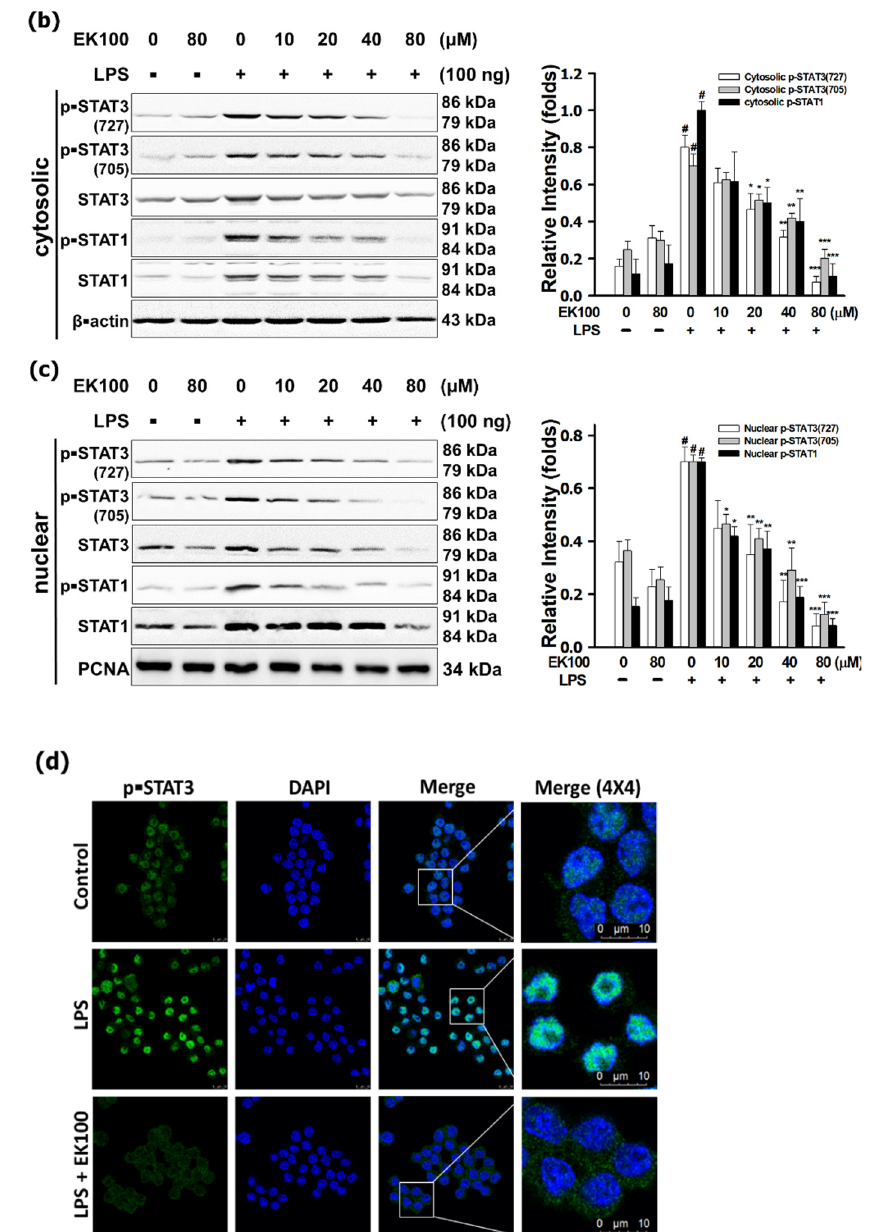
Figure 4. EK100 suppressed the MAPK/AP-1 pathways in LPS-stimulated RAW 264.7 cells. Cells were treated with 0, 10, 20, 40, and 80 µM EK100 for 1 h before being stimulated with 100 ng/mL LPS for 6 h. ( a ) The phosphorylation protein expressions JAK1/2 were analyzed. ( b ) The phosphorylation protein expressions p-STAT1 (705), p-STAT3 (727), and p-STAT3 (705) in the cellular cytoplasm were analyzed. ( c ) The phosphorylation and protein expression in the cellular nucleus of p-STAT1 (705), p-STAT3 (727), and p-STAT3 (705) were analyzed. ( d ) Cells were treated with 80 µM EK100 for 1 h before being stimulated with LPS for 6 h. p-STAT (Tyr705) was measured with IF staining. All experiments were designated and described in Materials and Methods. Data presented as folds means ± SEM compared with β -actin in the cellular cytoplasm or PCNA in the cellular nu- cleus of three independent experiments ( n = 3). # p < 0.05 compared with the control group, * p < 0.05, ** p < 0.01, and *** p < 0.001 compared with LPS alone group. 3.5. EK100 Activated the Nrf2/HO-1 Signaling Pathway in LPS-Stimulated Macrophage-Like Cells In RAW 264.7 cells, EK100 stimulated antioxidative Nrf2 protein expression signifi- cantly in the cellular nucleus of RAW 264.7 cells. At 80 µM EK100, and compared with the LPS group, Nrf2 protein expression increased from 0.22 ± 0.02 to 0.81 ± 0.06 folds in the